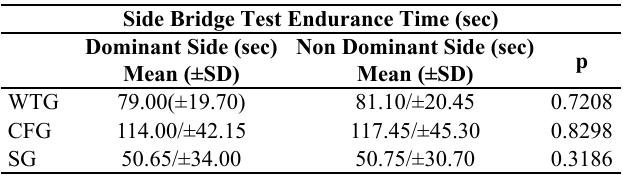
Table 1. Mean values and standard deviation of the weight train - ing, crossfit and sedentary groups, dominant and non-dominant side bridge test endurance time (in seconds).